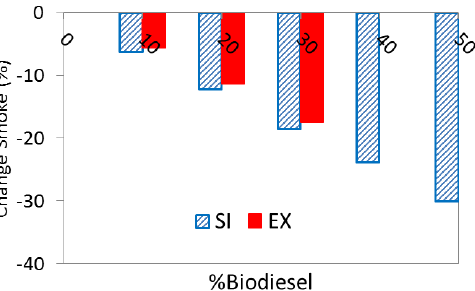
Figure 18. Relationship between smoke and biodiesel blending ratio of simulation (SI) and experiment (EX).